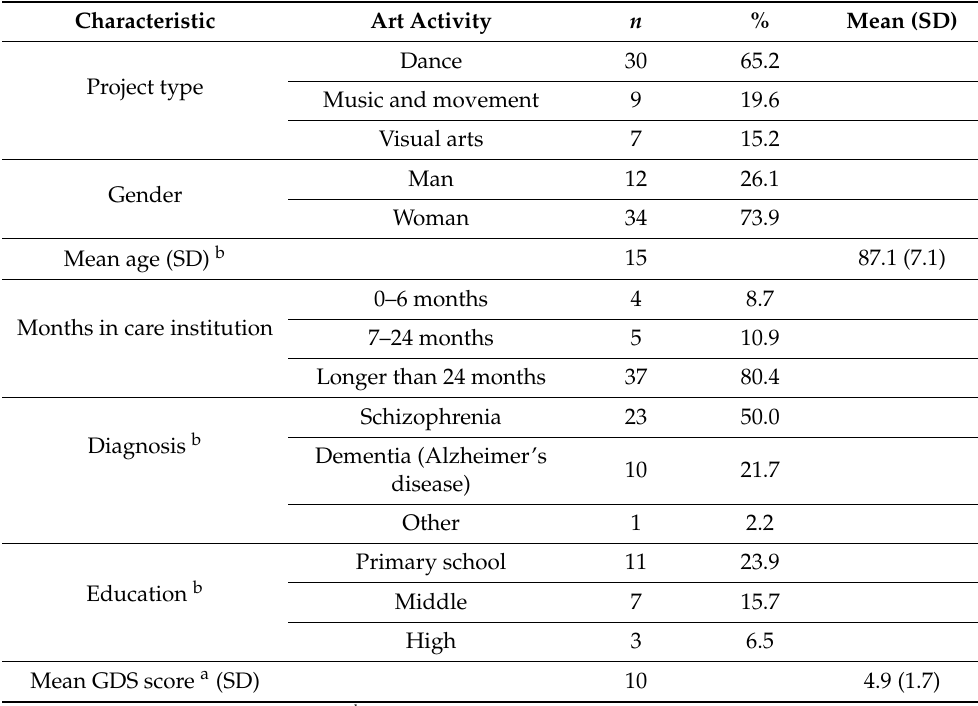
Table 2. Characteristics of the participants ( n =